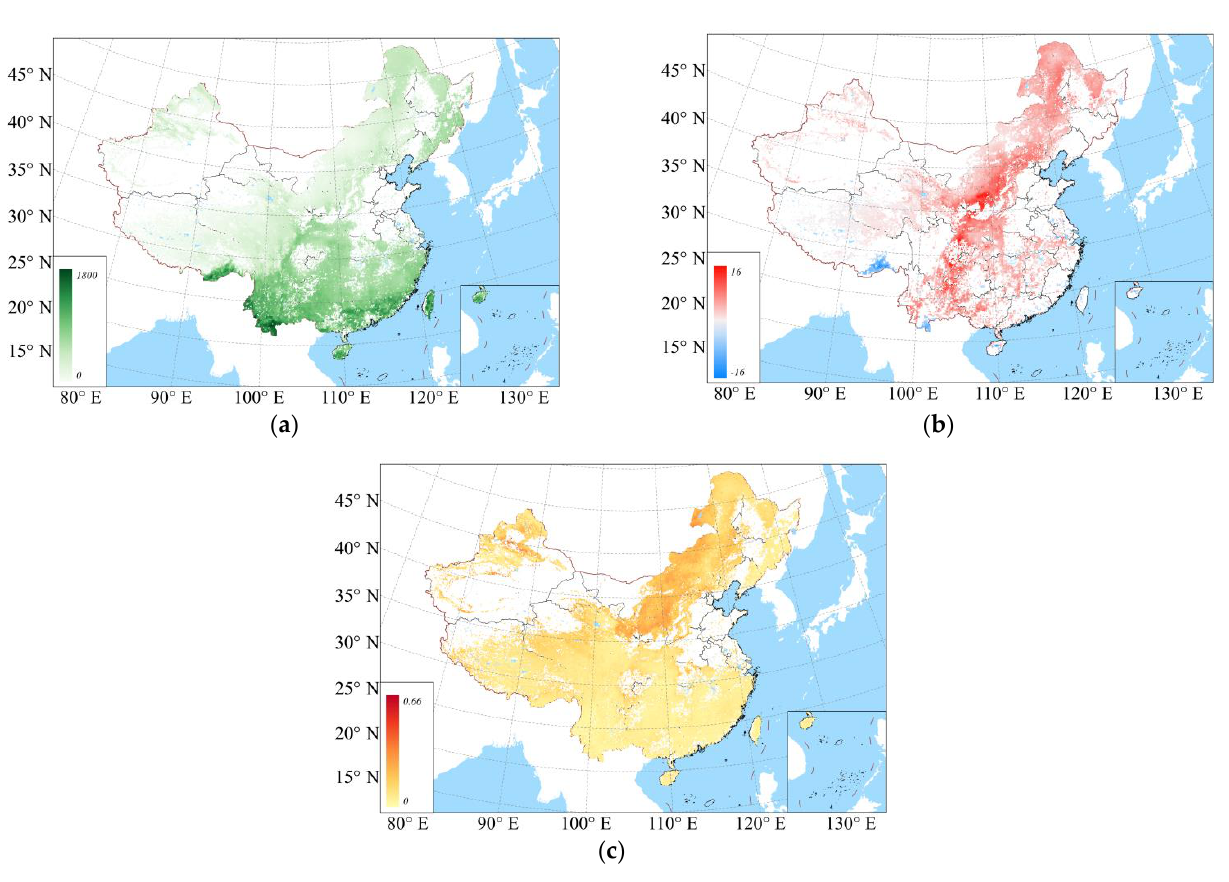
Figure 2. Spatial distribution of annual average NPP across China (g C·m -2 ·yr -1 ) ( a ); Linear NPP trend (g C·m -2 ·yr -1 , >0.05 confidence level) ( b ); Coefficient of variation ( c ).